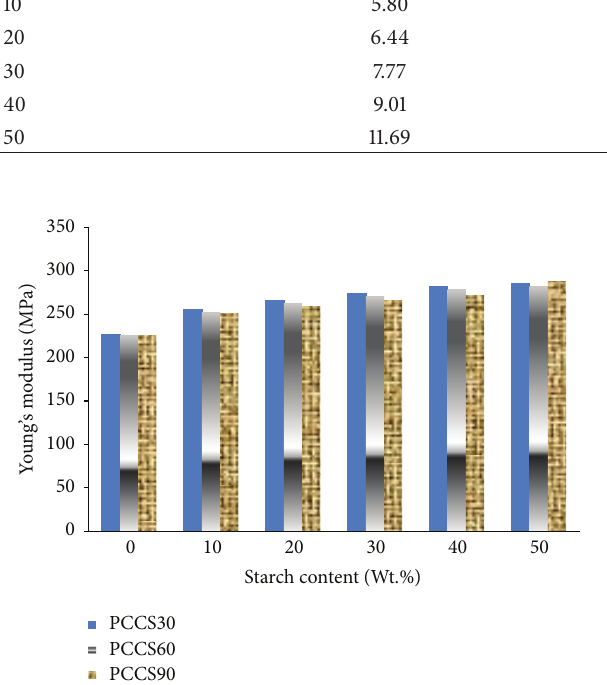
Figure 6: Young’s modulus of PP/PCCS blends after the soil burial